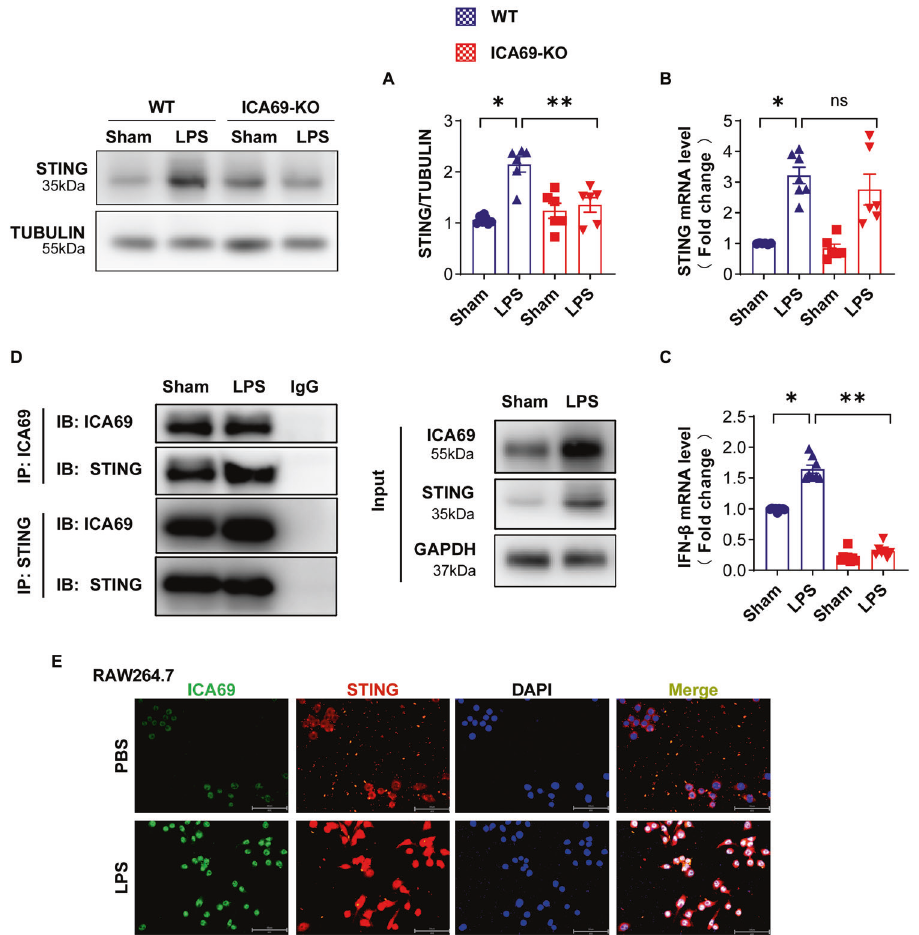
corresponding TUBULIN level, and the changes are shown in the histograms ( n = 6). B , C The mRNA levels of STING and IFN- β in indicated groups that were stimulated with LPS or PBS for 12 h ( n = 6). The data are expressed as the mean ± standard error of the mean.* P < 0.05